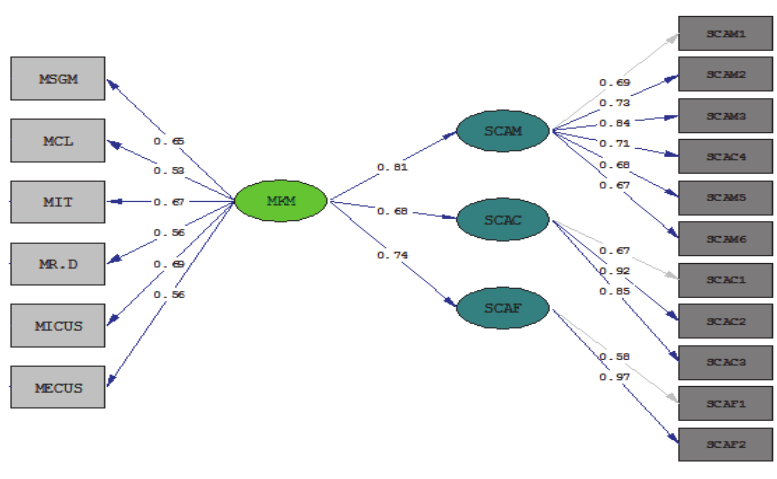
Fig. 3. Structural Relationship model between MKM and SCA